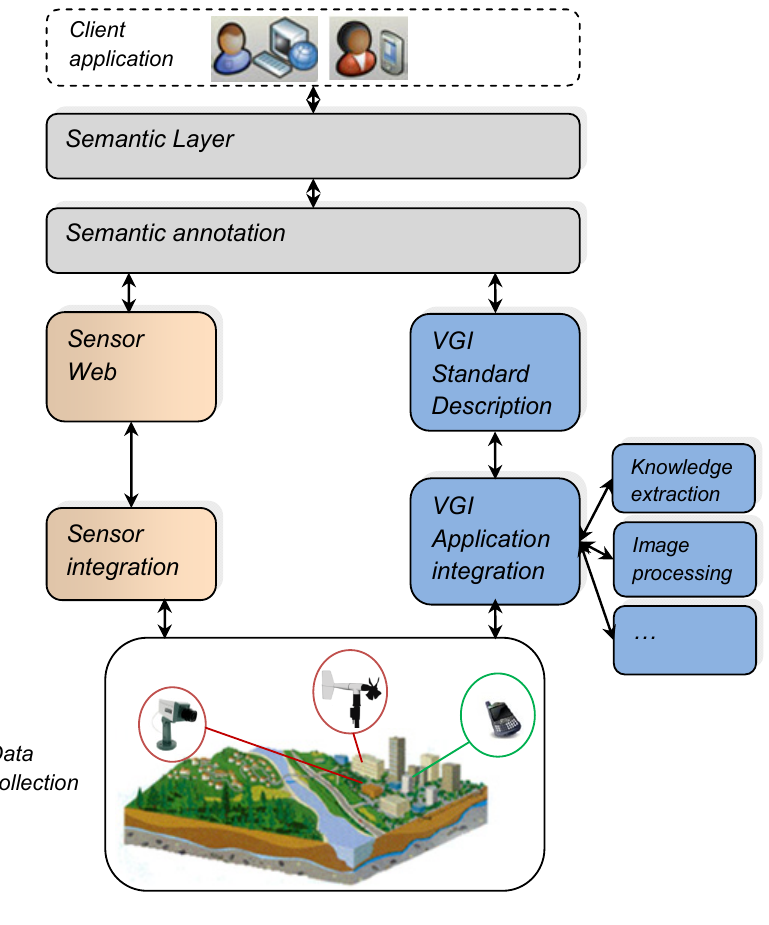
Figure 2. Framework for semantic interoperability of sensor data with